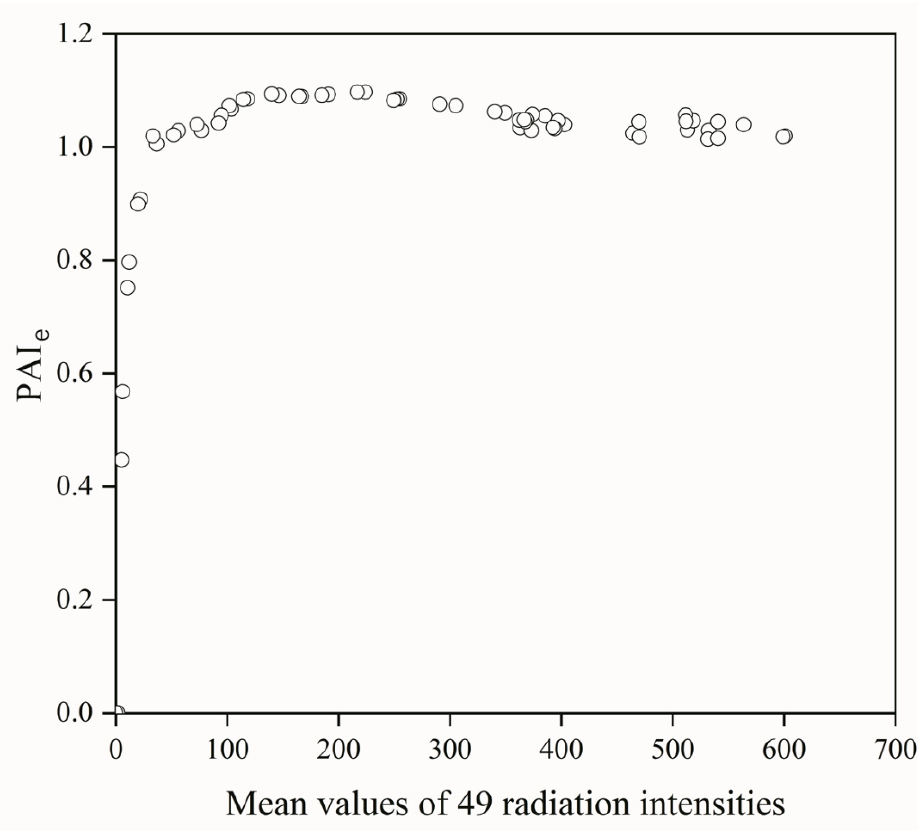
Figure 5. The relationship between the mean values of light intensity and the corresponding PAI e .